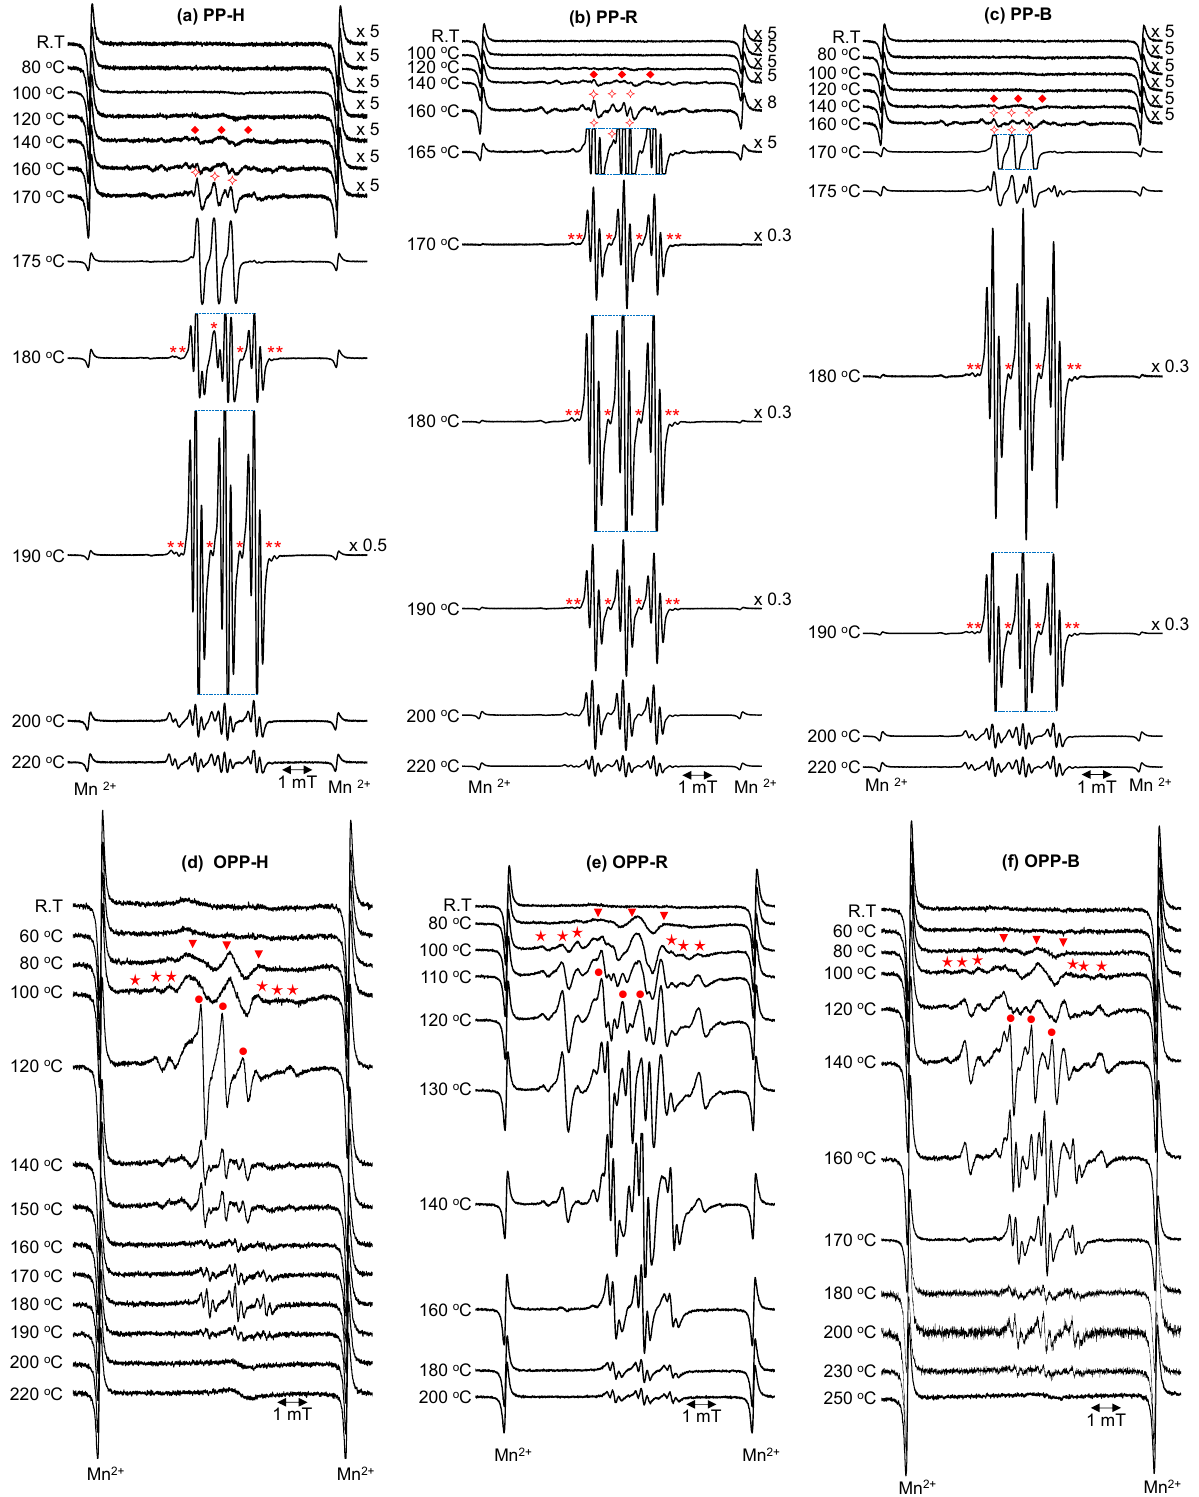
Figure 5. ESR spectra of pristine and oxidized PP granules impregnated with TTBNB during step- wise heating from RT to over 200 °C: ( a ) PP-H, ( b ) PP-R, ( c ) PP-B, ( d ) OPP-H, ( e ) OPP-R, and ( f ) OPP-B. The dashed lines represent spectra with the nine-line signal part-cut due to the limited accumulation range. The details of symbols, , , , , , and , are described in the text.